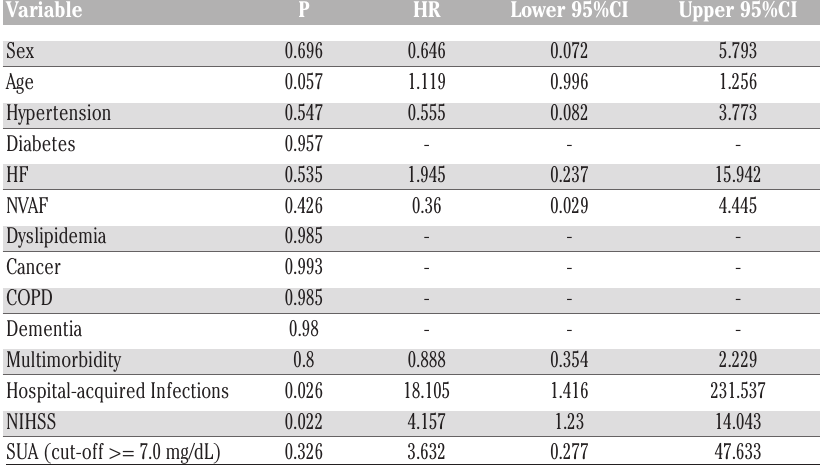
Table 4. Multivariate Cox regression analysis in the subpopulation with normal renal